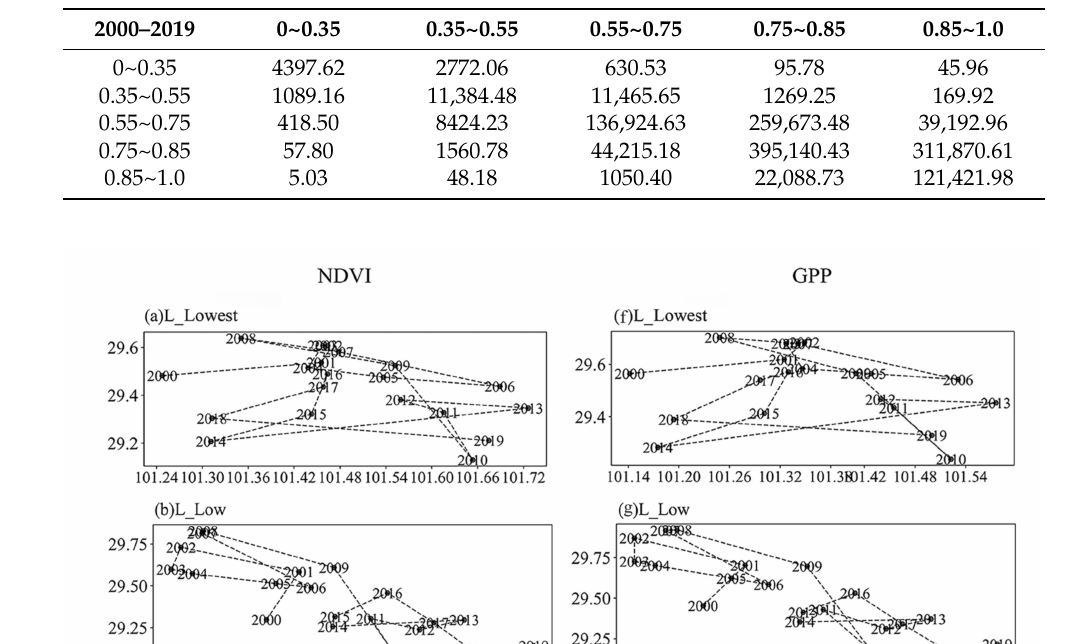
Table A1. Transformation matrix of NDVI grades from 2000 to 2019 (km 2 ).